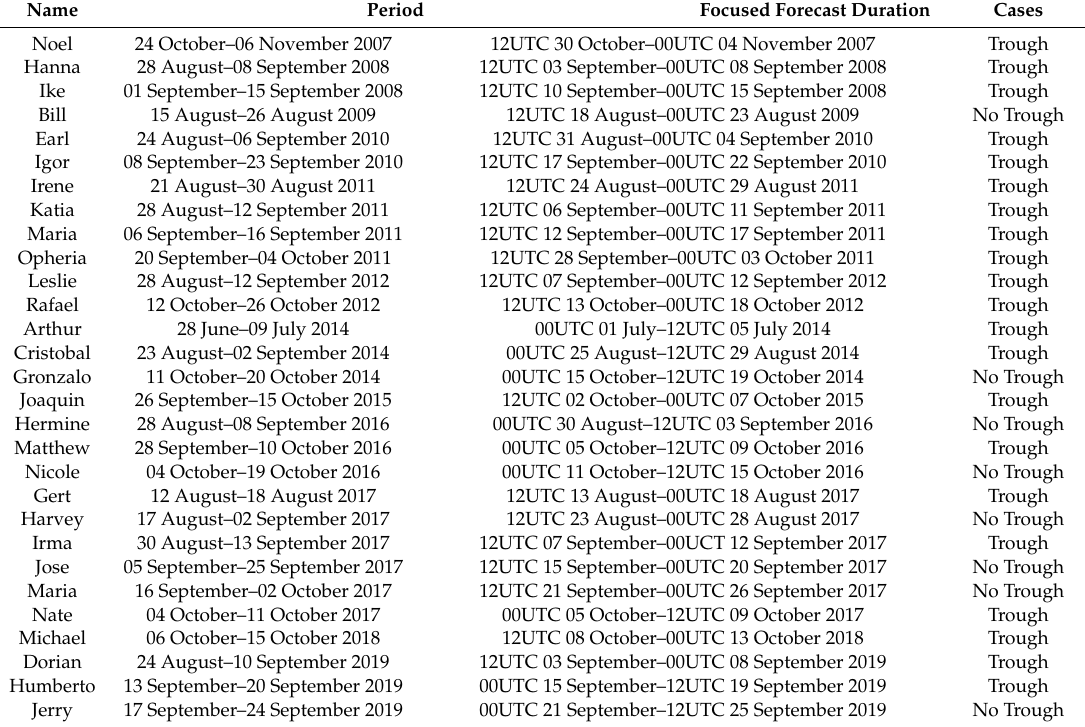
Table 1. Details of the hurricanes between 2007 and 2019 that are reviewed in this